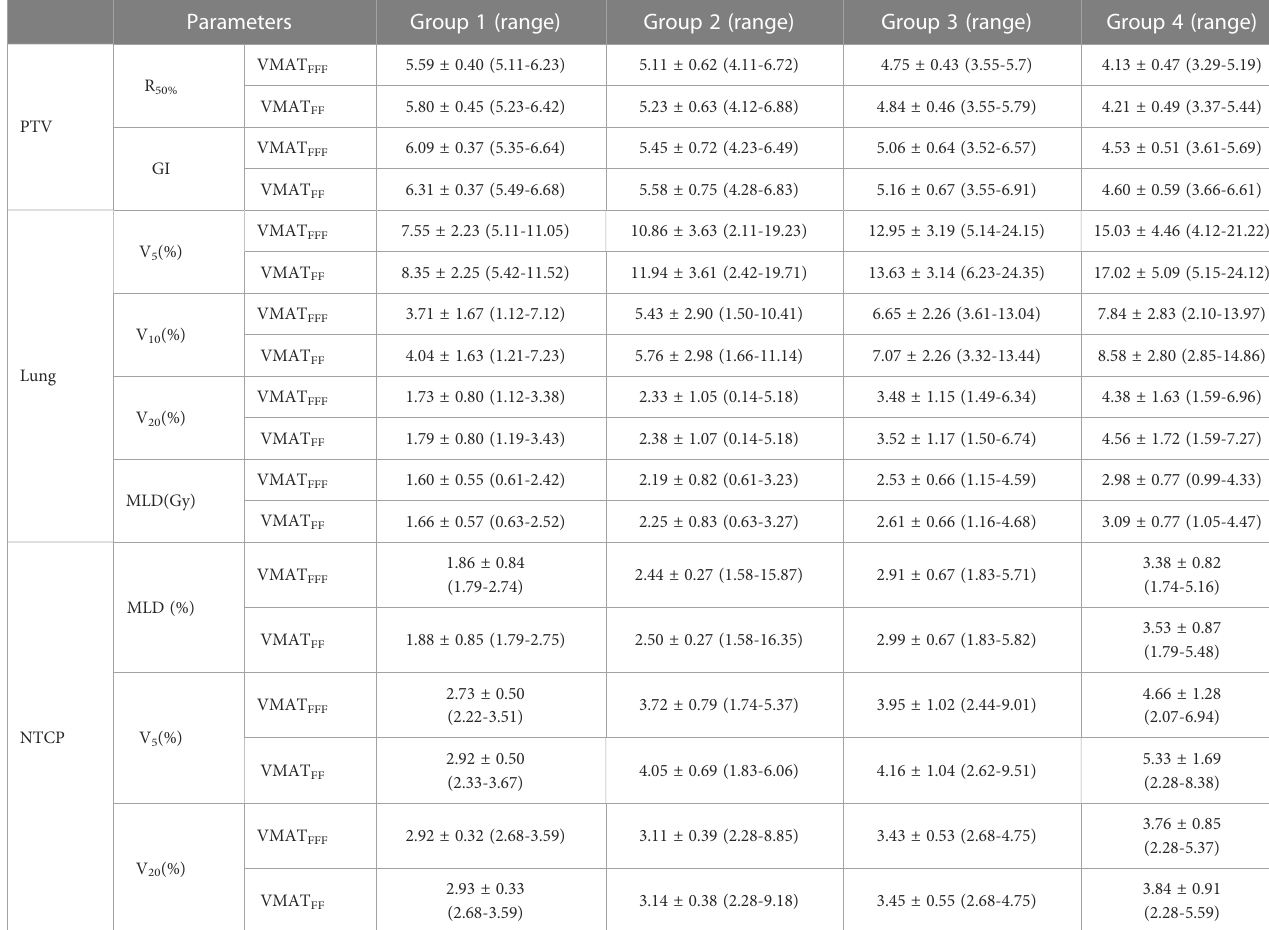
TABLE 6 Summary of the results for parameters of PTV, lung and NTCP (mean ± standard)in four group according to the PTV volume.